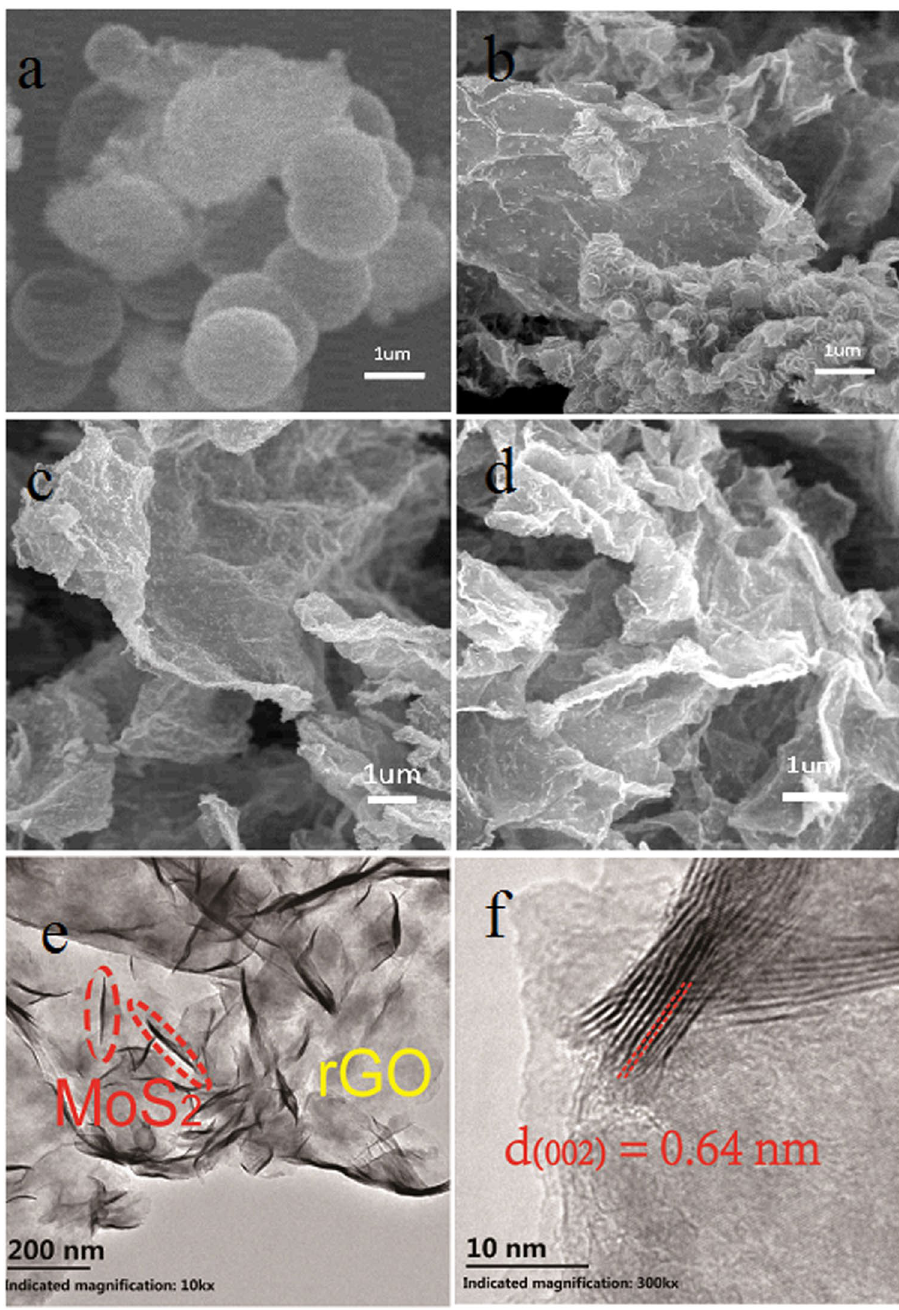
Figure 3. SEM images of the ( a ) pristineMoS 2 and ( b – d ) MoS 2 @rGO2 composites, ( e , f ) the TEM images of curves of the MoS 2 @rGO composite at a constant current density of 0.2 A g − 1 are shown in Fig. 5b. The initial dis- charge curves consist of three plateaus at 1.5–0.8 V, 0.75–0.4 V and 0.4–0.01 V vs. Na + /Na, respectively, which are consistent with the CV results. In the subsequent discharge, the plateaus are disappeared and replaced by a long slopes curve as a result of the conversion reaction mechanism, which is in good agreement with previous reports. The cycling stability of the pristine MoS 2 and MoS 2 @rGO composites were further evaluated at 0.2 A g − 1 as shown in Fig. 6a. The initial discharge capacity of the pristine MoS 2 is about 470 mAh g − 1 , but drops quickly to 105 mAh g − 1 after 100 cycles, primarily due to the serious structural collapse and aggregation of the hollow MoS 2 spheres during the charging/discharging process. On the contrary, MoS 2 @rGO-1,2,3 composites deliver high initial discharge capacities of 521, 543 and 610 mAh g − 1 with a corresponding first cycle coulombic efficiency of 74.6%, 66.9% and 67.4%, respectively. After the first cycle, the discharge capacity of the composites increased slowly until a stable range of 381, 441 and 412 mAh g − 1 (50th cycle). MoS 2 @rGO-2 reveals the largest reversible